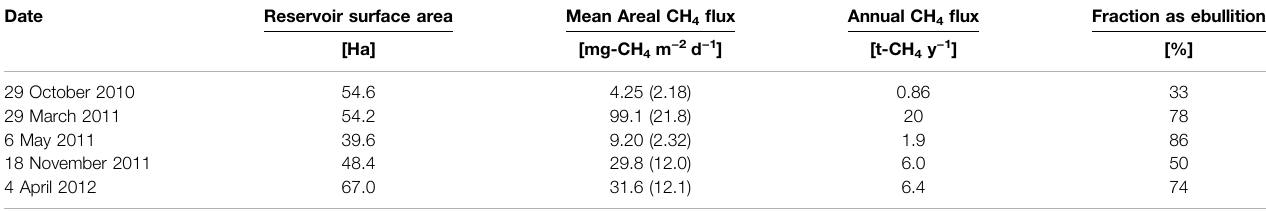
TABLE 1 | Areal mean (±s.d.) and annual methane fl uxes from Cotter Reservoir and the fractional contribution of ebullition to the total fl